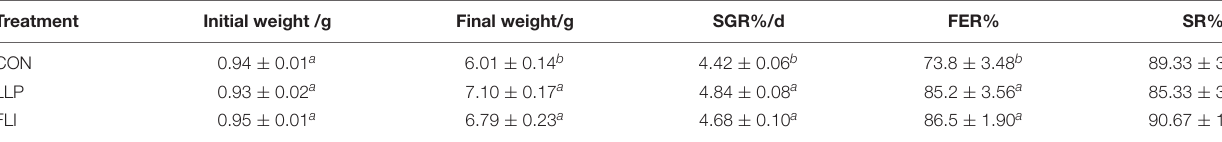
TABLE 4 | Growth performance of P. vannamei .